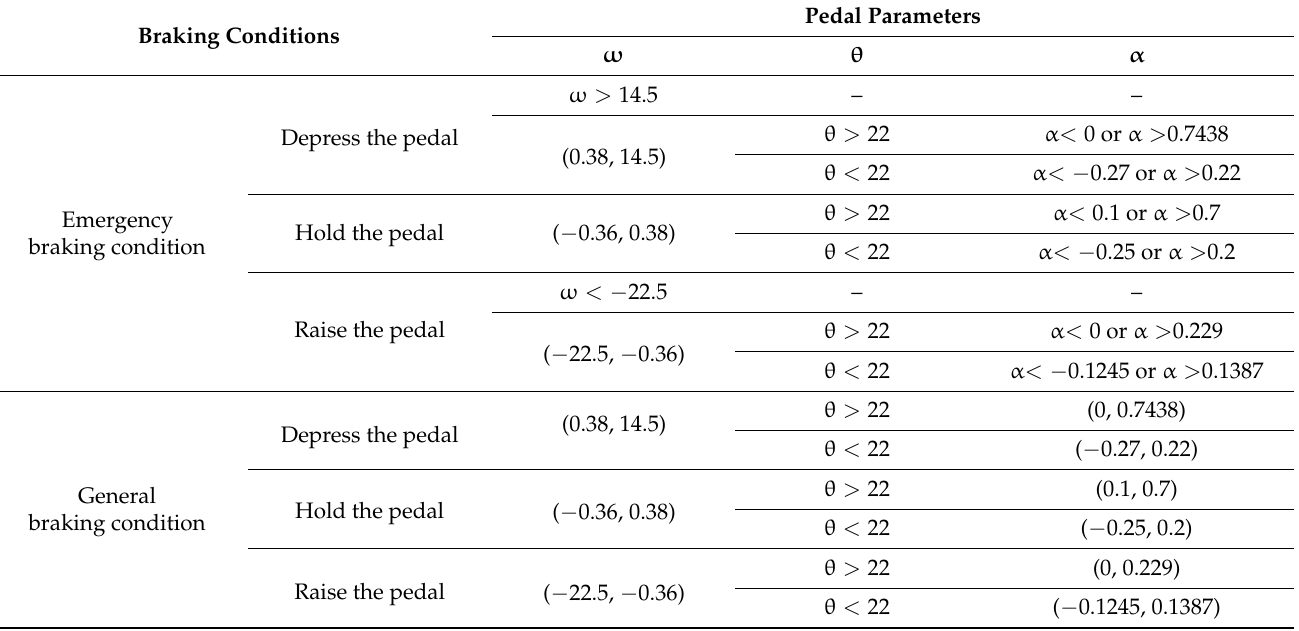
Table 1. Classification of braking conditions and parameter